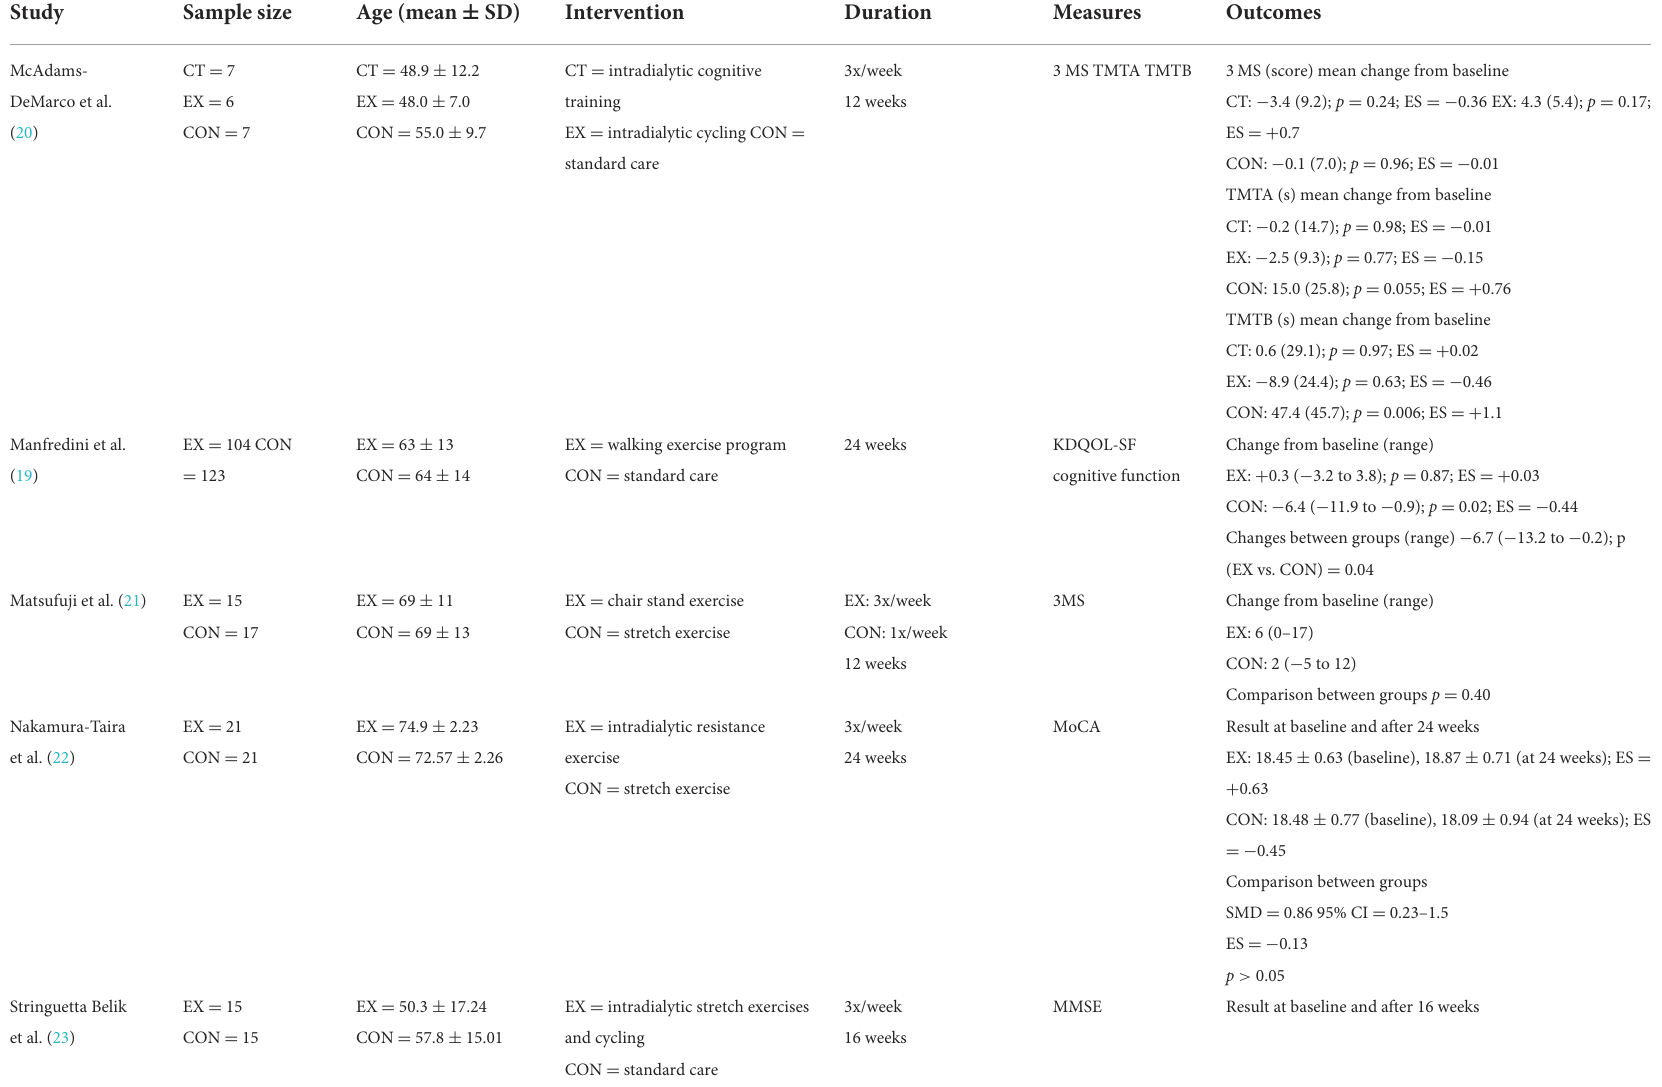
TABLE 3 Characteristics of included